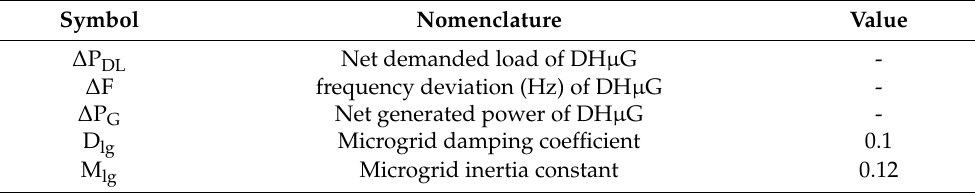
Table 1. Symbols and their corresponding